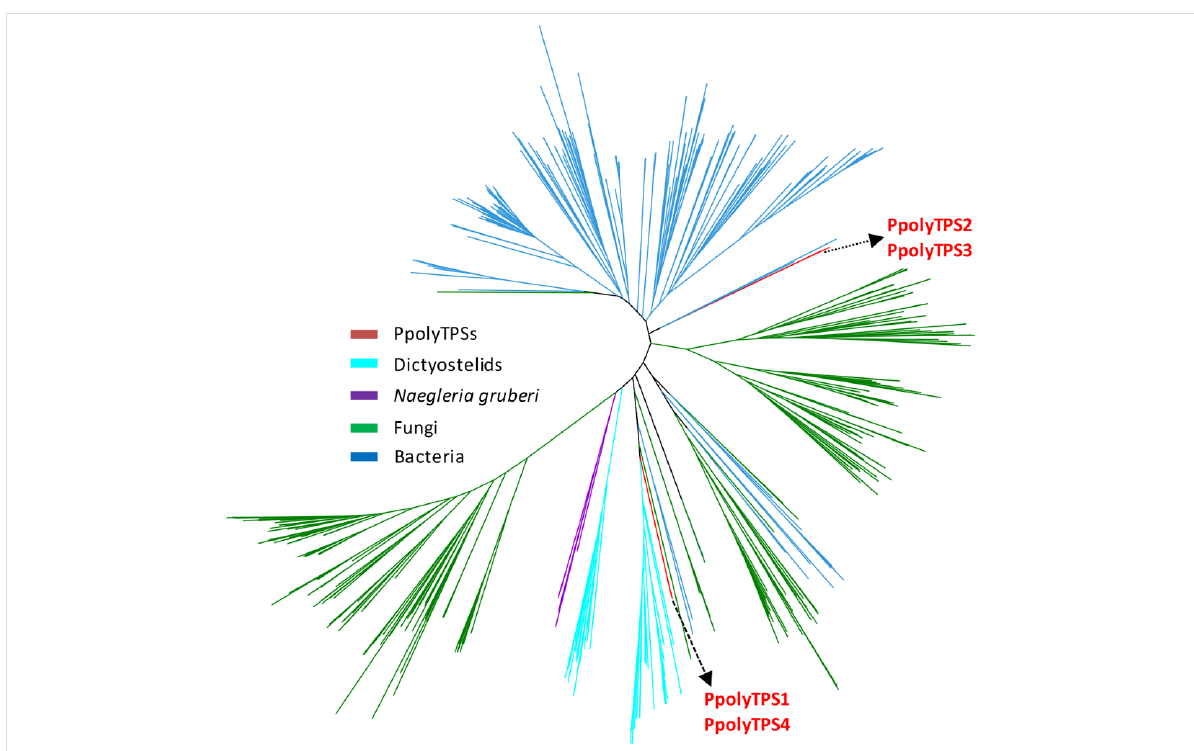
Figure 4: Phylogenetic analysis of PpolyTPSs with TPSs from dictyostelid social amoebae (Dictyostelids), the amoebae Naegleria gruberi , fungi, and bacteria. TPSs from dictyostelid social amoebae were obtained from the study [15]. TPSs from another amoeba N. gruberi , fungi, and bacteria were obtained from the study [14]. TPSs from different lineages were